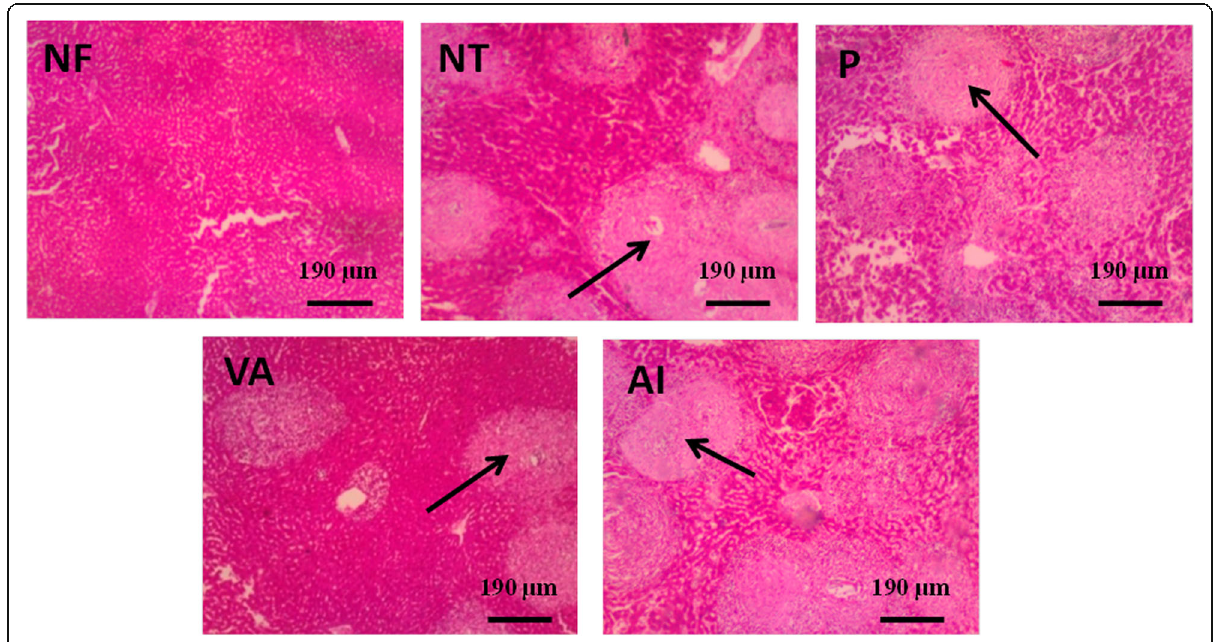
Fig. 6 Photomicrographs (H&E × 200) of liver granuloma in S. mansoni -cercariae infected mice from various experimental groups. Single headed arrows (